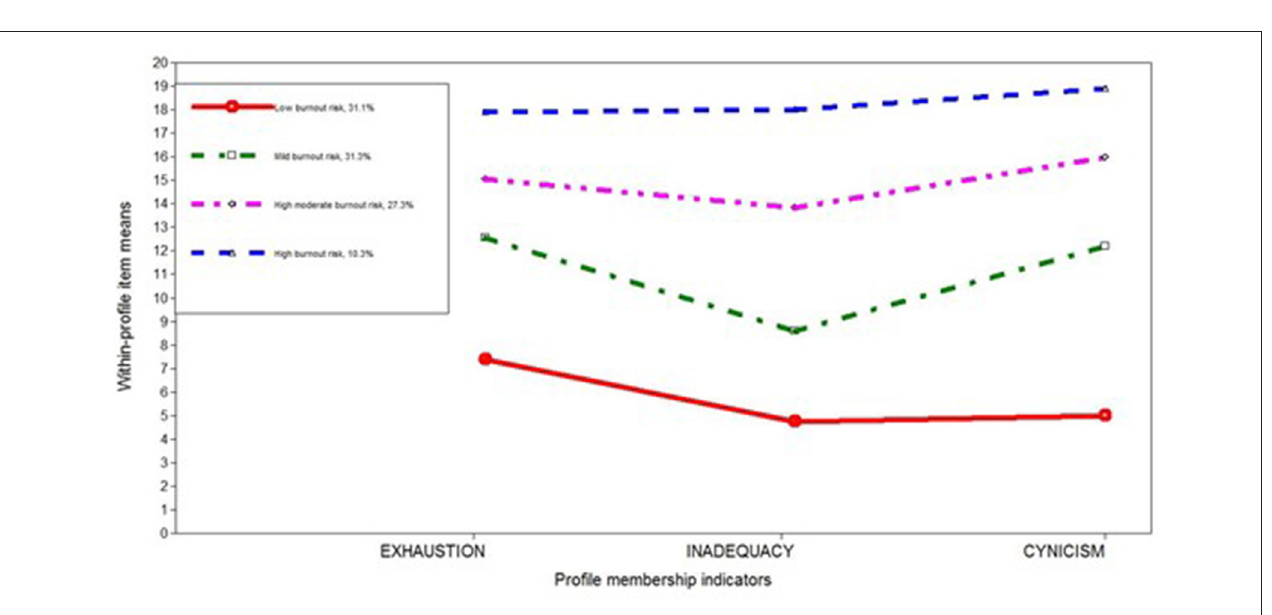
FIGURE 1 | Parameter estimates for the four-profile model of TB risk; within-profile item means.